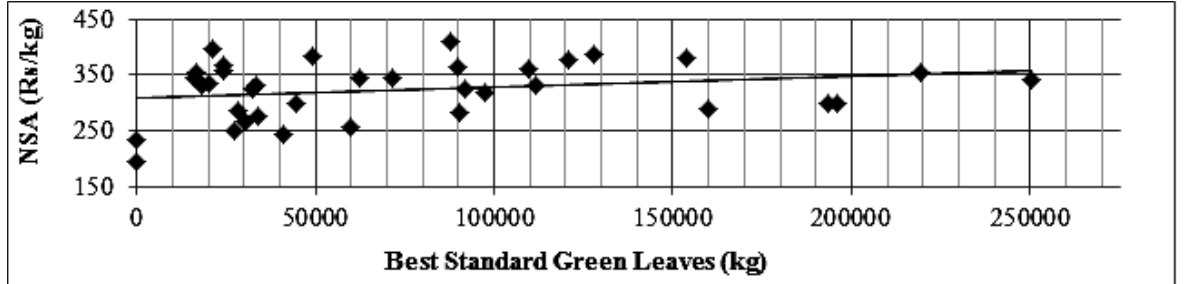
Fig 10: Relationship of Own Leaf Quantity with NSA in Nuwara Eliya According to the fig 11, best leaf standard green leaf is given positive relationship for the NSA. But same leaf standard has given different NSA values throughout the time period. Flavor developed in made tea varies with the time due to changing favorable climate during that time. It could be the leading factor for price variation for same leaf standard.